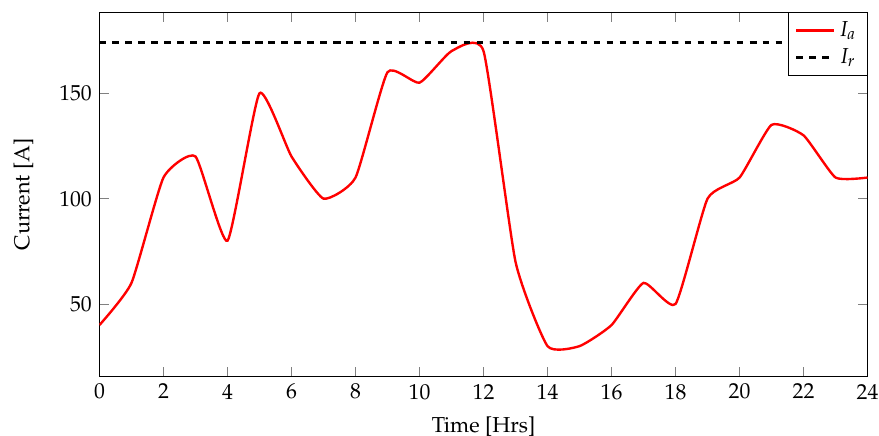
Figure 3. Example of a current profile to illustrate rating issues, where I a is the actual current and I r is the current used for static